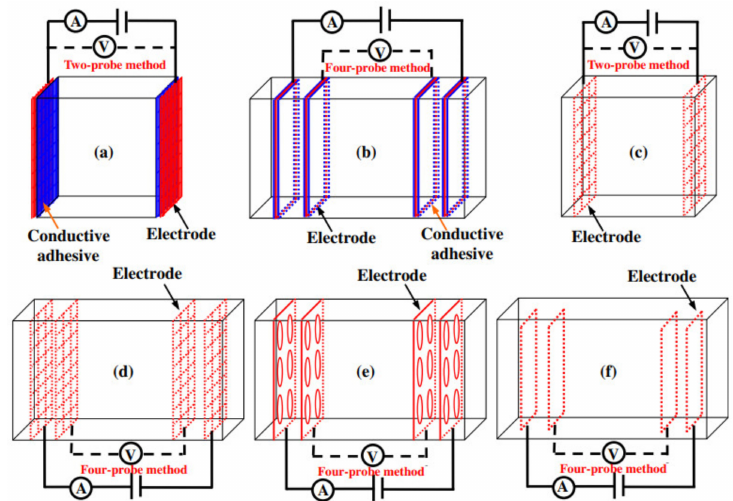
Figure 2. Fixing the style and layout of electrodes in self-sensing concrete; ( a , b ): electrodes at- tached on the surface; ( c – f ): embedded mesh, perforated plate or loop electrode. Reproduced with permission from [4], Elsevier, 2015.